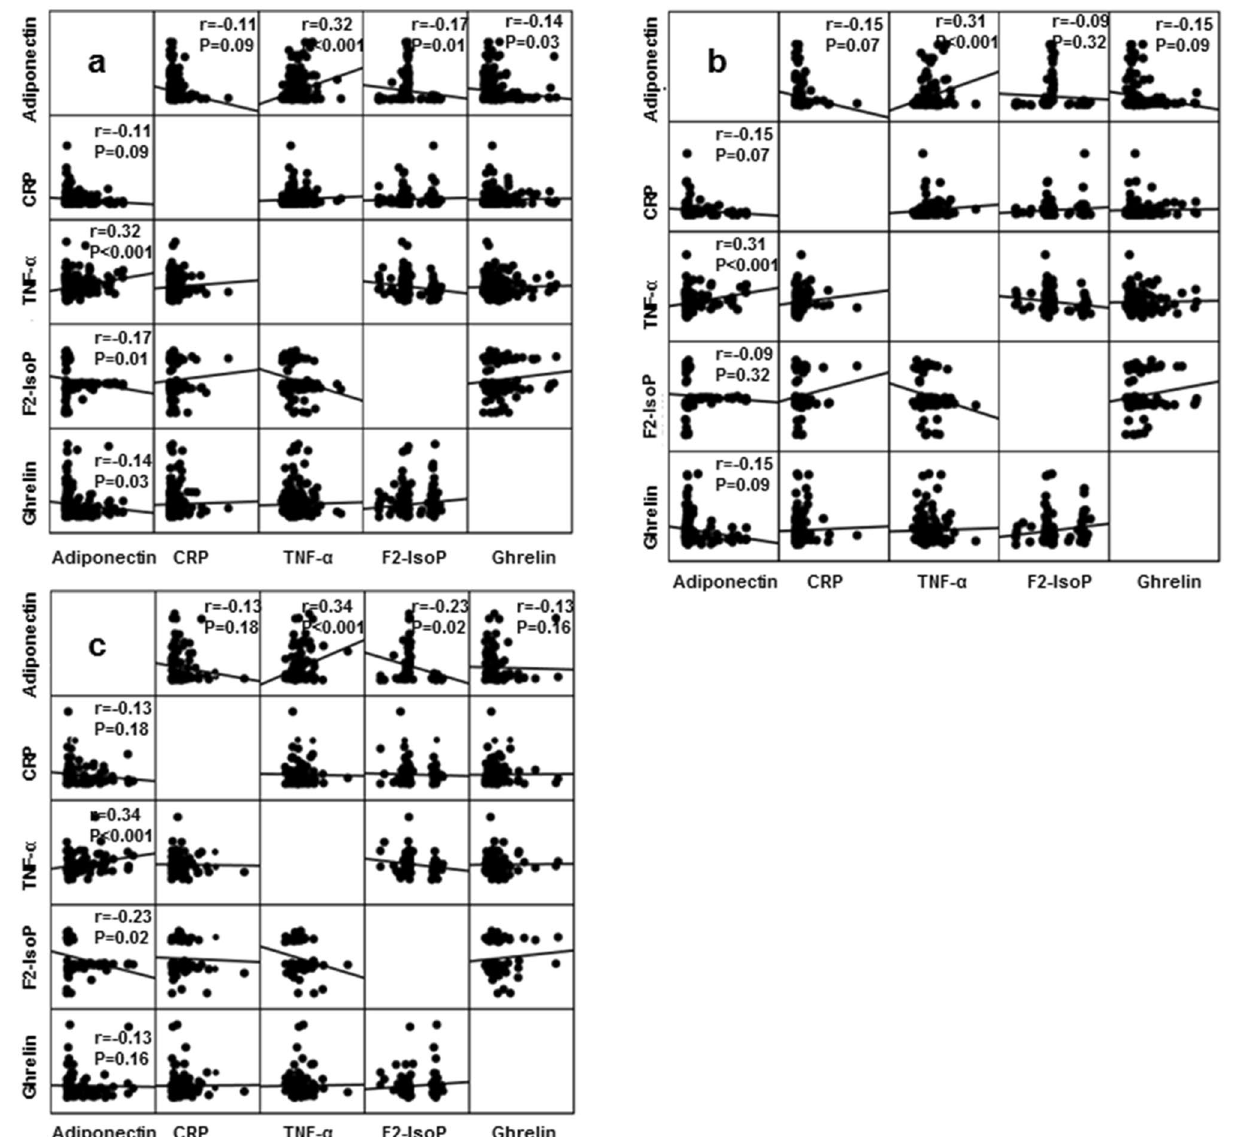
Figure 2. Correlation matrix for associations between serum adiponectin (mcg/ml) markers of inflammation, oxidative stress and appetite hormones in the whole population (n = 261) ( a ), a subgroup of patients with comorbidity index ≤ 4 (n = 142) ( b ), and a subgroup of patients with comorbidity index > 4 (n = 119) ( c ). Adjustments for age, sex, DM status, dialysis vintage, comorbidity index, residual renal function, smoking and